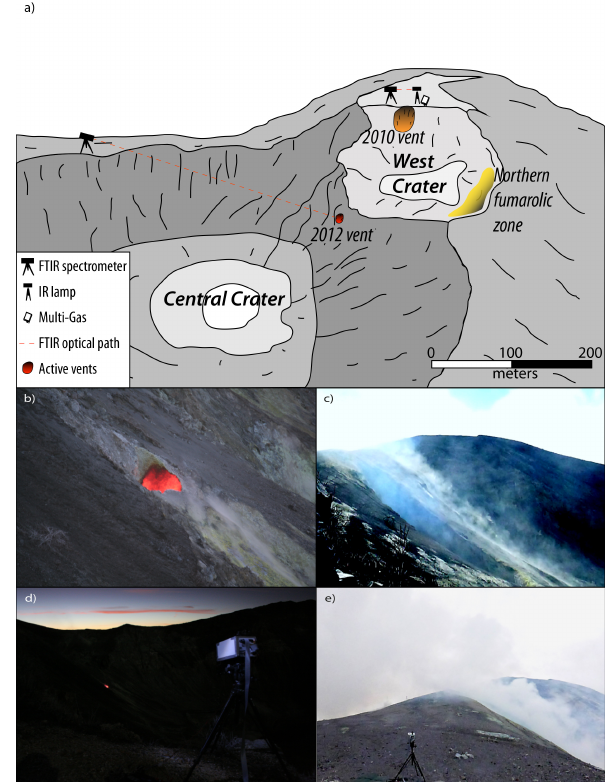
Figure 2. (a) Summit area of Turrialba looking due south, showing (not drawn to scale) the location of the three main vents and fu- marolic fields together with the various locations of the FTIR spec- trometer and “multi-gas” instrument. (b) Close-up view of the 2012 vent at sunset. (c) Close-up view of the 2010 vent. (d) Picture of the instrumental setup on 25 March 2013 with the FTIR spectrometer pointing at the 2012 vent (courtesy of Kayla Iacovino). (e) Picture of the instrumental setup on 26 March 2013 with the FTIR spec- trometer pointing at an infrared lamp across the wind-blown mixed plume directly south of the 2010